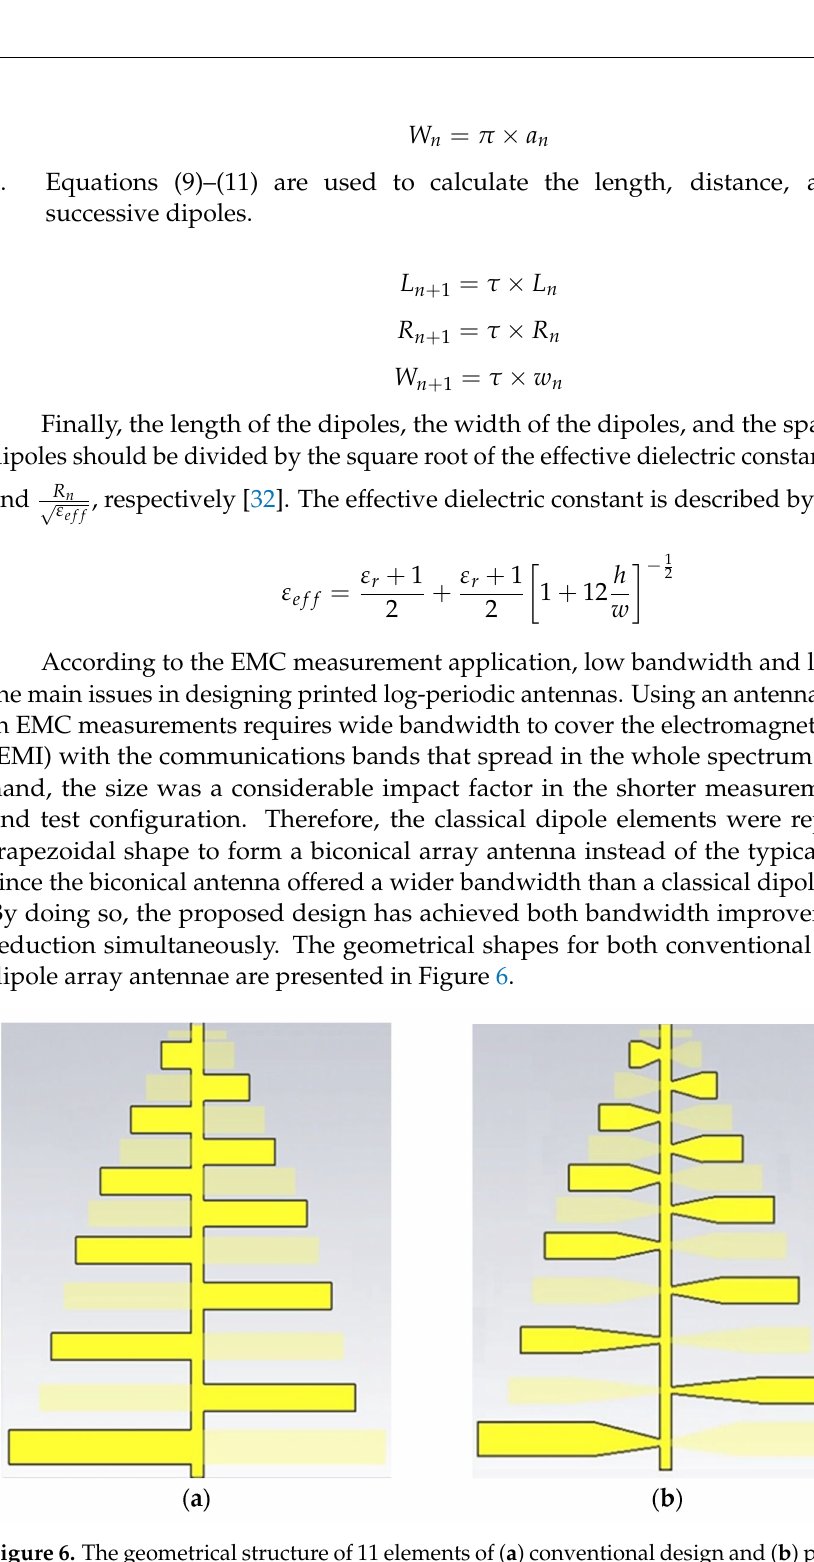
Figure 6. The geometrical structure of 11 elements of ( a ) conventional design and ( b ) proposed